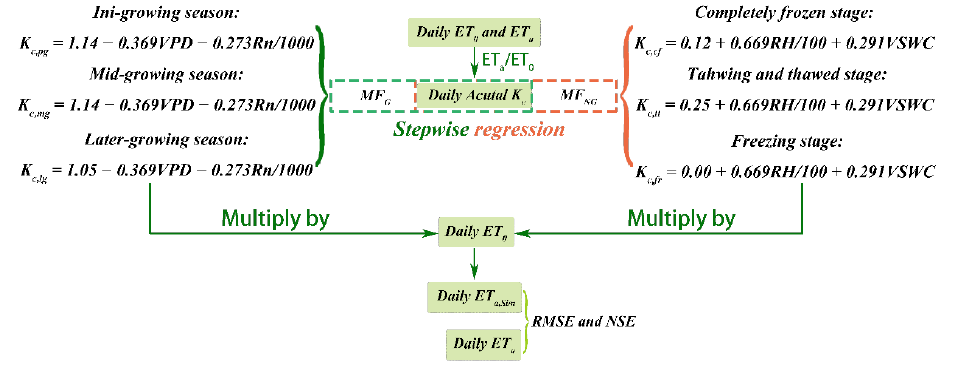
Figure 11. Correction and parameterization schemes of K c ; rectangle with rounded corners and green background implies the used or calculated data. Green arrow implies the processing of data and the dashed rectangle implies the stepwise regression between the data and main influencing factors. Brace represents the result. ET a,Sim represents the actual evapotranspiration calculated by the reference evapotranspiration.